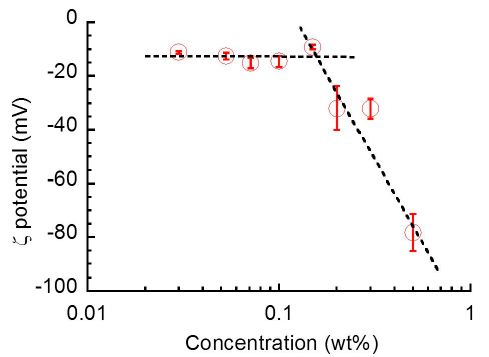
Figure 7. Sacran concentration dependence of the zeta potential for sacran aqueous solutions with various concentrations.